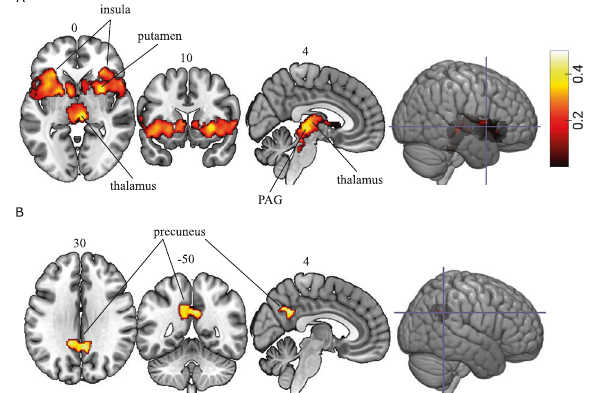
Fig. 2 Genetic in fl uence on brain function supporting fear conditioning. A The genetic in fl uence on brain responses during fear learning and B safety learnine3g. Displayed voxels survived a cluster-based statistic of P < 0.05 family-wise error corrected. The color bar indicates genetic in fl uence ( h 2